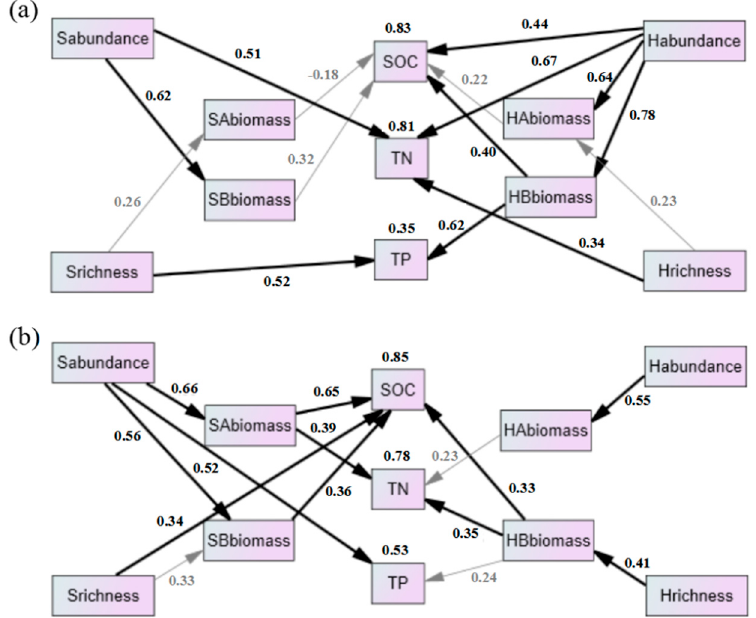
Figure 7. Direct and indirect effects of understory vegetation on SOC, TN and TP in R. pseudoacacia (( a ) CMIN/DF = 1.106, GFI = 0.841, CFI = 0.981, RMSEA = 0.077) and P. tabuliformis forest (( b ) CMIN/DF = 1.201, GFI = 0.819, CFI = 0.959, RMSEA = 0.109). Bold black arrows indicate significant correlations ( p < 0.05). The number above the box represents the multiple R 2 . Sabundance, shrub abundance; Srichness, shrub richness; SAbiomass, shrub aboveground biomass; SBbiomass, shrub belowground biomass; Habundance, herb abundance; Hrichness, herb richness; HAbiomass, herb aboveground biomass; HBbiomass, herb belowground biomass.